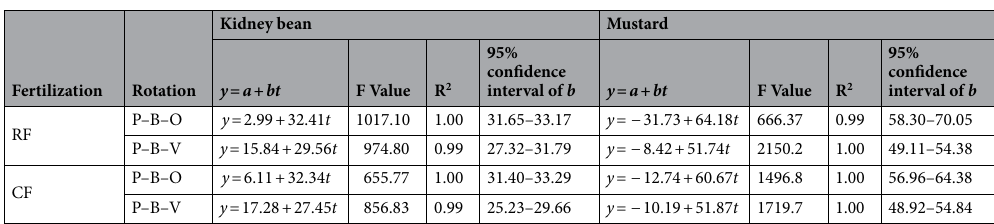
Table 7. Linear grey model of yield trends of kidney bean and mustard for different treatments.